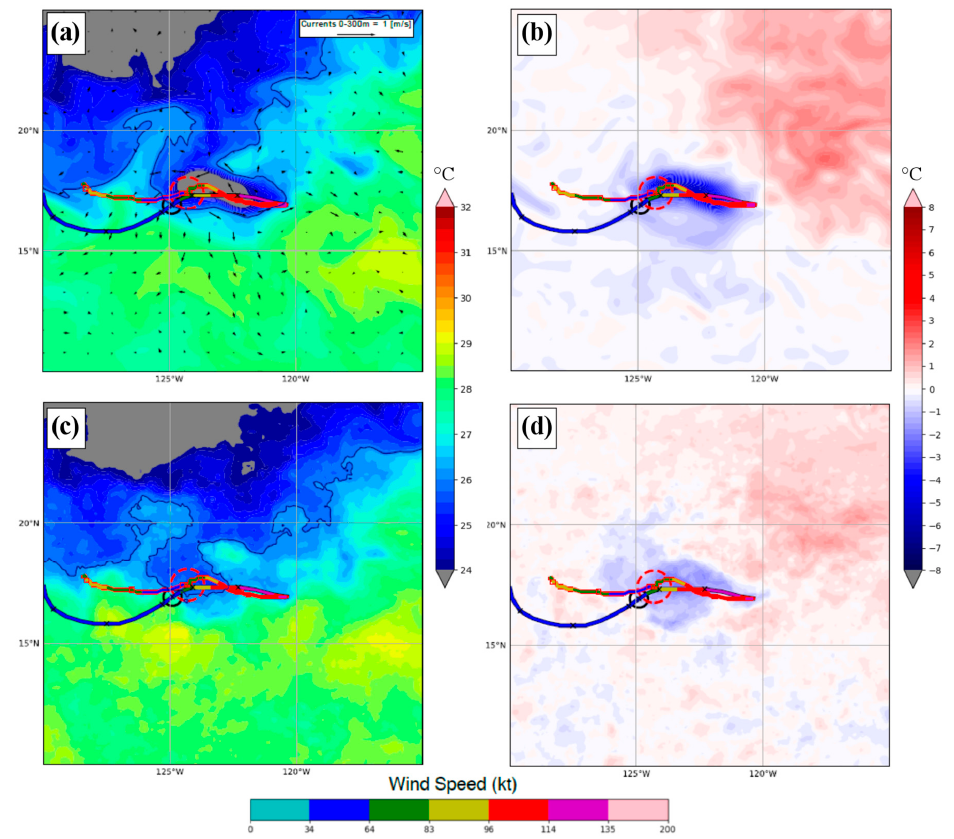
Figure 11. As in Figure 7, except for the case study of Kiko (EP132019), initialization time of 0600 UTC 15 September 2019. Fields shown are as of forecast lead time of 60 h (1800 UTC 17 September 2019): SST ( a , c ) and SST change ( b , d ) for ( a , b ) MPIPOM-TC model output and ( c , d ) MWIR satellite SST. A detailed comparison of model results to observation is beyond the scope of this paper.